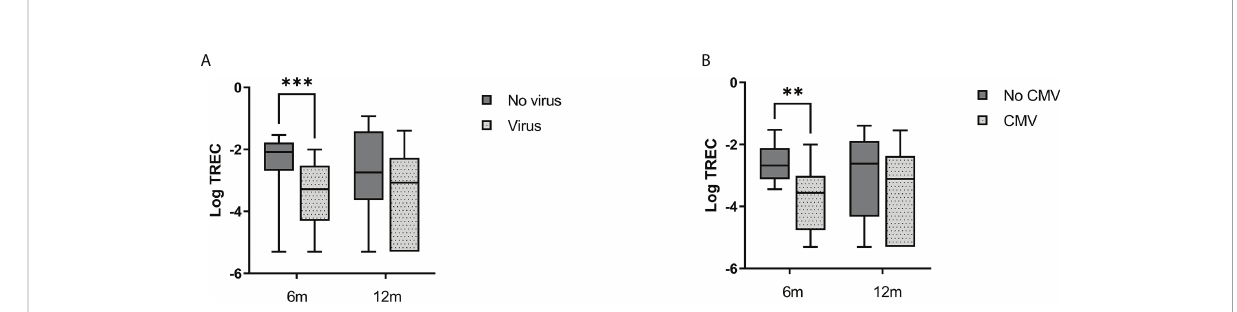
FIGURE 2 Incidence of viral infections and CMV reactivation was associated with lower TREC levels. (A) Virus (light gray boxes) indicated at least one viral infection with a veri fi ed pathogen within the fi rst 100 days from HSCT. (B) CMV (light gray boxes): CMV-reactivation in CMV seropositive patients within the fi rst 100 days from HSCT. Median with boxes for interquartile range and whiskers for range. Mann-Whitney U-test. **p < 0.01, ***p <